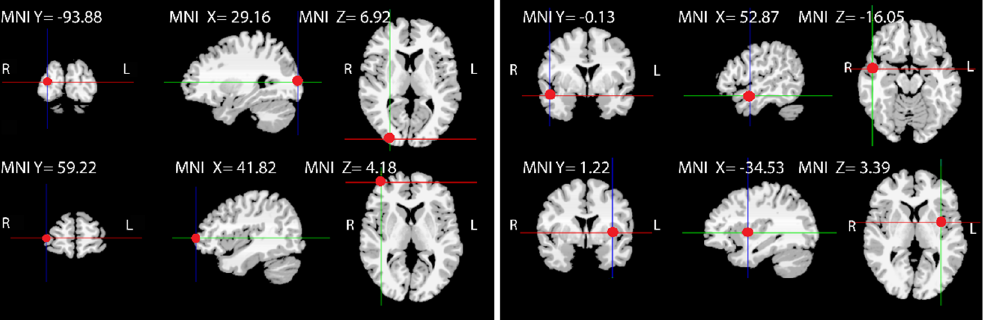
Figure 4. Locations (MNI-coordinates) of the dipoles the Ground Truths have in common. Left: Far–Superficial fixed dipoles. Right: Far–Deep fixed dipoles.